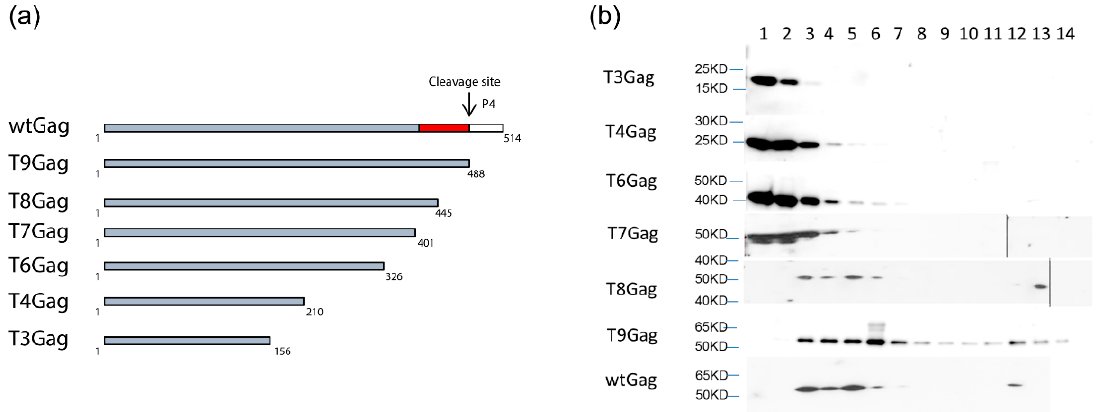
Figure A1. FFV capsomere and capsid formation by wt and C-terminal FFV Gag deletion mutants. ( a ) Schematic of the FFV C-terminal Gag deletion mutants with p4 and the GR-rich domain marked by white and red boxes, respectively. ( b ) HEK293T cells were transfected in 10 cm dishes with 12 μ g truncated or wt Gag expressing plasmid. At 36 h post transfection, cytoplasmic extracts were prepared and ultracentrifuged through a 10%–60% continuous sucrose gradient at 32,000 rpm for 2 h. For each sample, 20 fractions (from 1 to 20) were collected from the top of the gradient and analyzed by immunoblotting by using an anti-Gag MA antiserum. Fractions 15–20 are not shown because no bands were visible. Fractions 1–2: unassembled Gag proteins; fractions 3–7: capsomeres; fractions 12–14 capsids. Shortened from detailed data in [92].